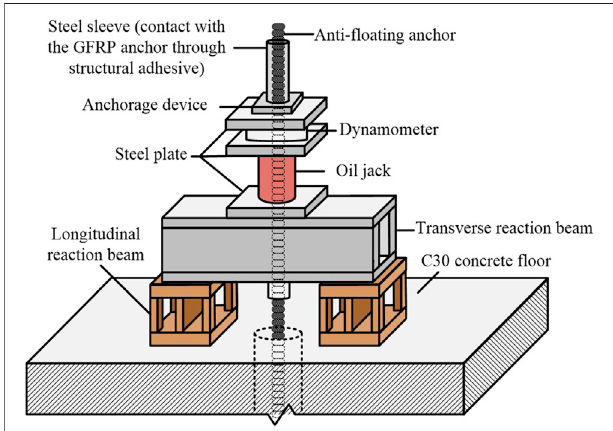
FIGURE 5 | Schematic diagram of the anchor pull test system.